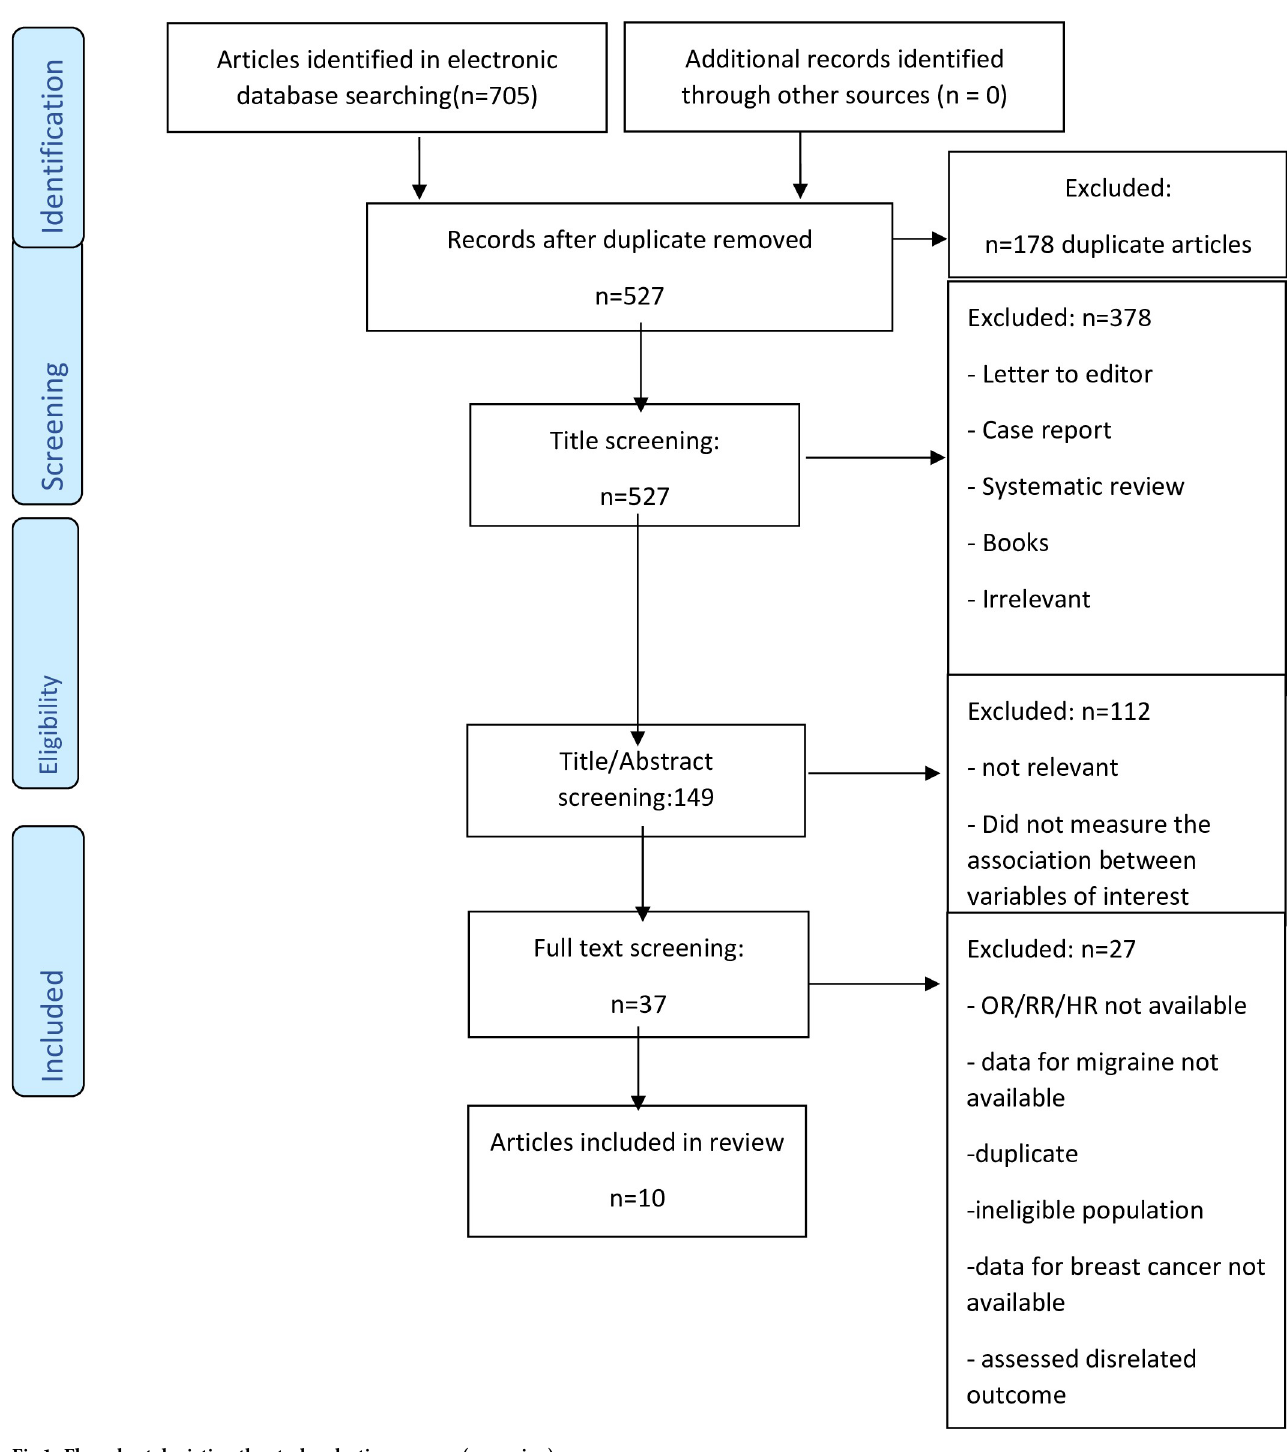
Fig 1. Flow chart depicting the study selection process